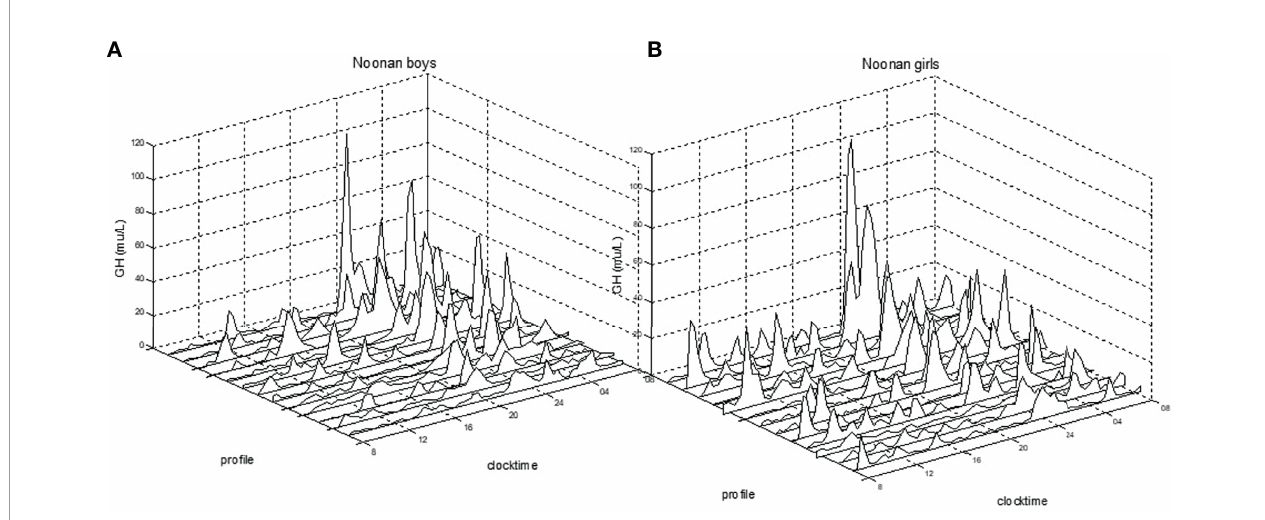
FIGURE 1 | Individual 24h-GH pro fi les for prepubertal boys (A) and for girls (B) with Noonan syndrome. Clock time for integrated 20/30 min samples versus GH mU/L (divide by 3 for ug/L), measured with polyclonal